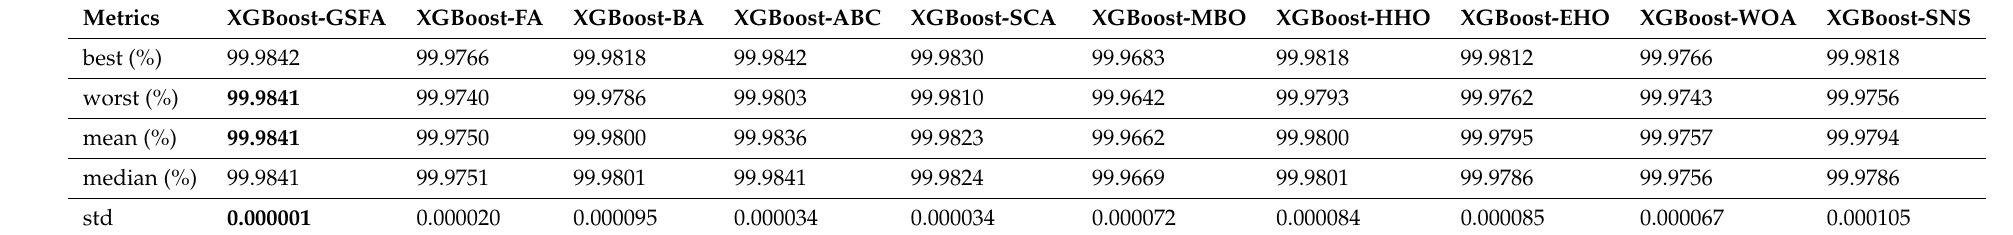
Table 7. XGBoost Credit Card Fraud with the SMOTE—general